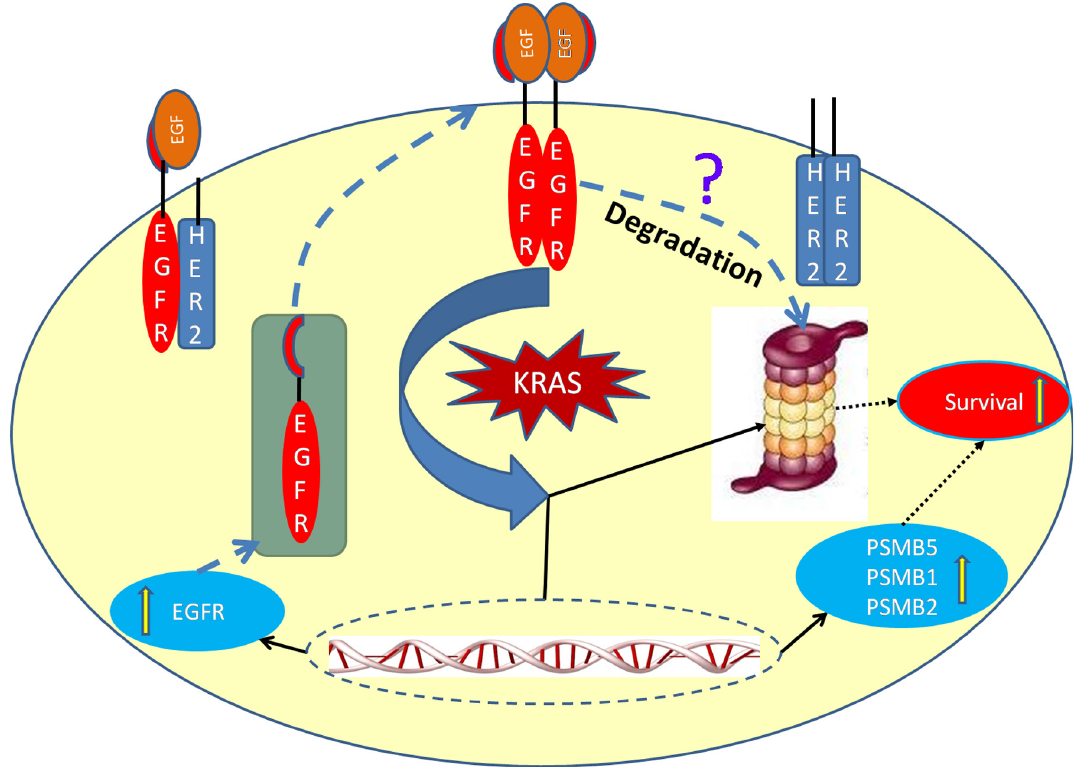
Figure 6. Schematic representation is showing that the EGF/EGFR signaling axis overwhelms the action of K-Ras mutation and signi fi - cantly enhances proteasome expression and activity possibly contributing to cancer cells survival. Taking into consideration that EGF also increases the expression of EGFR, it is plausible to suggest that the EGF-mediated proteasome activation could possibly lead to enhanced EGFR degradation leading to autoregulation of EGF – EGFR